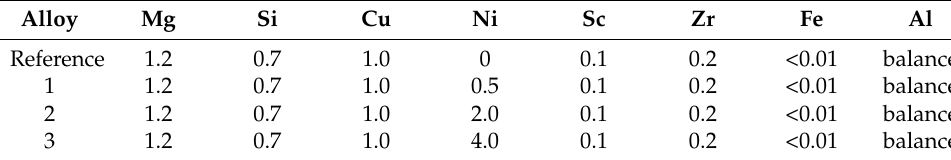
Table 1. Chemical composition of the studied alloys